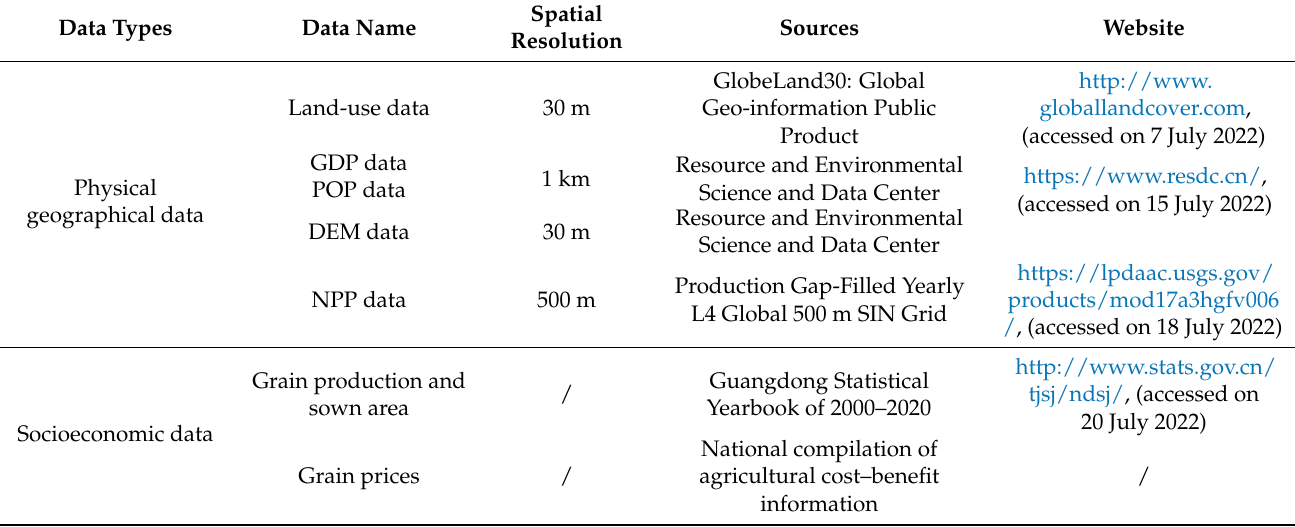
Table 1. Study data sources.